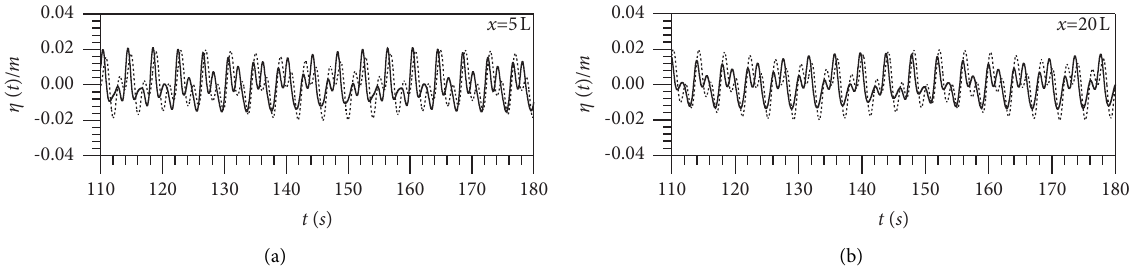
Figure 3: Comparisons of the wave profiles between the calculation results (solid line) and theoretical results (dashed line) at different gauge locations for case